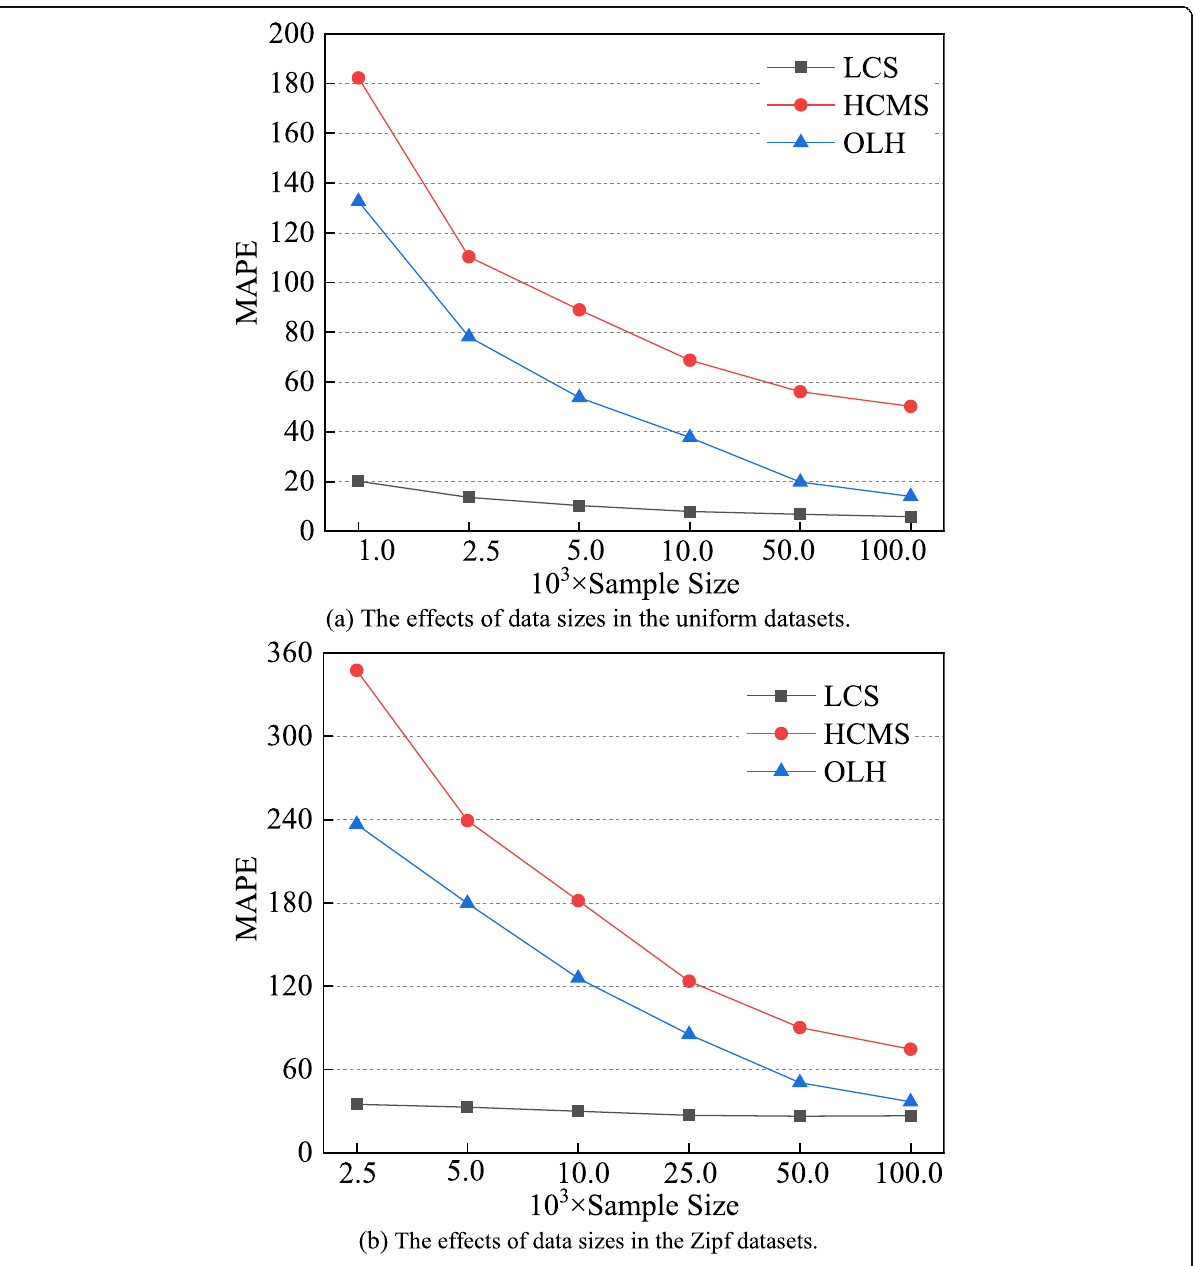
Fig. 4 The effects of different data sizes. a The effects of data sizes in the uniform datasets. b The effects of data sizes in the Zipf